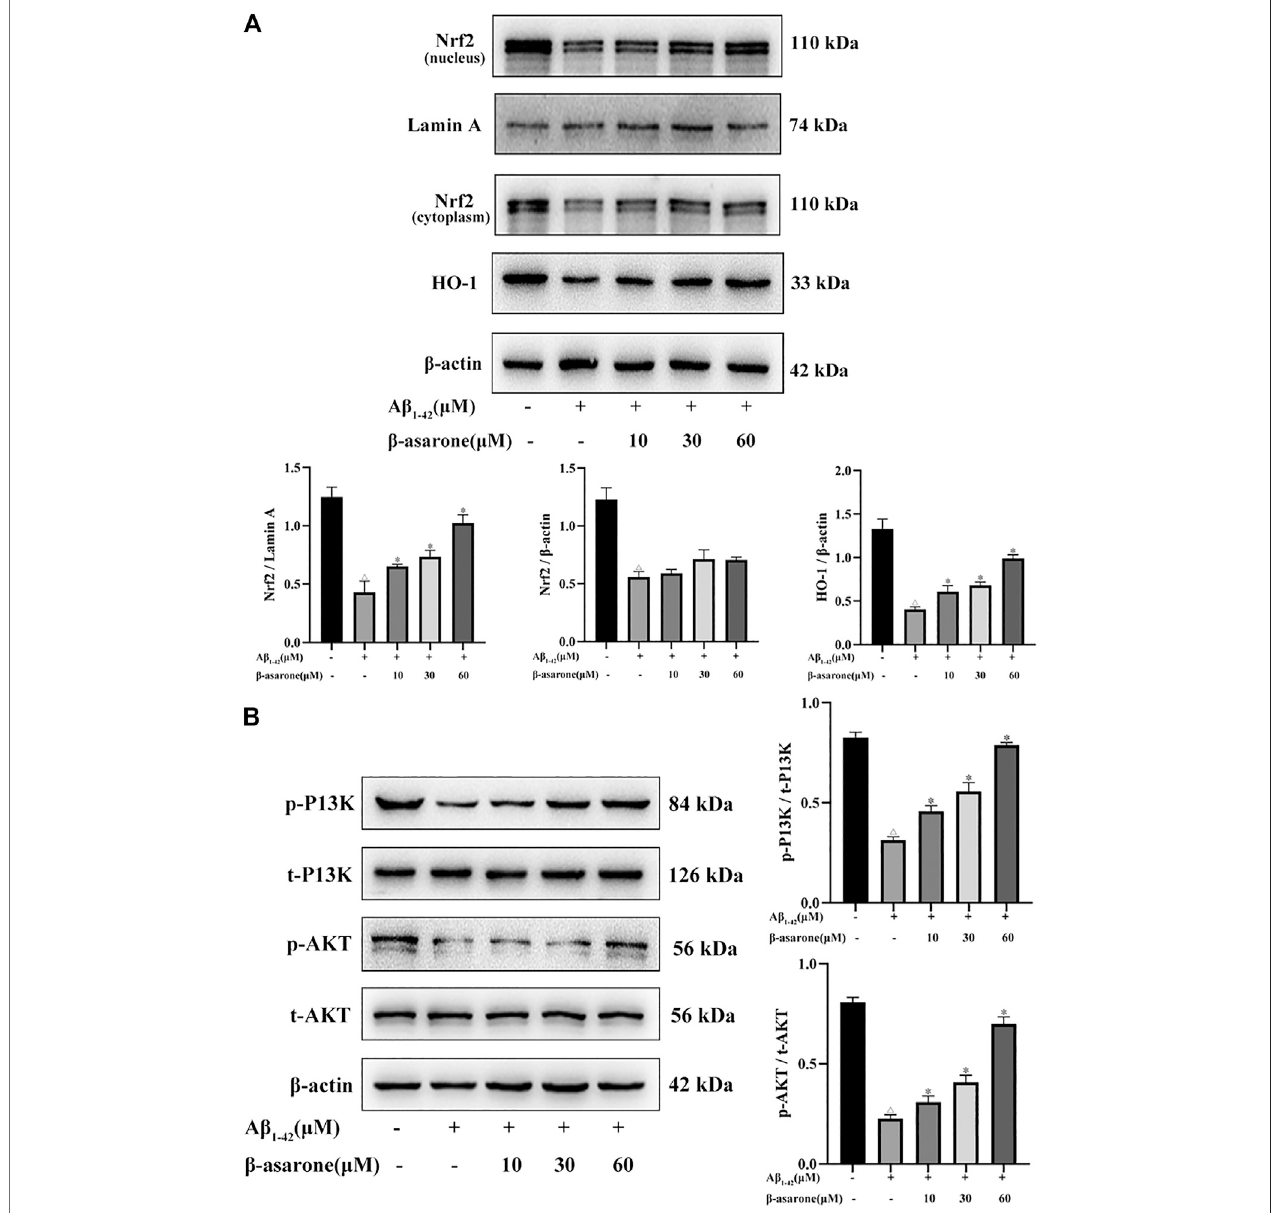
FIGURE 6 | Effect of β -asarone on A β 1 – 42 -induced protein expression of P13K/Akt/Nrf2/HO-1. (A) The protein expression levels of Nrf2 in the nucleus and cytoplasm and HO-1 were detected by Western blot. (B) The levels of P13K, p-P13K, Akt, and p-Akt were also determined by Western blot. △ p < 0.05 compared with the control group; * p < 0.05 compared with the A β 1 – 42 alone treatment group. The data were expressed as mean ± SD from three independent experiments.